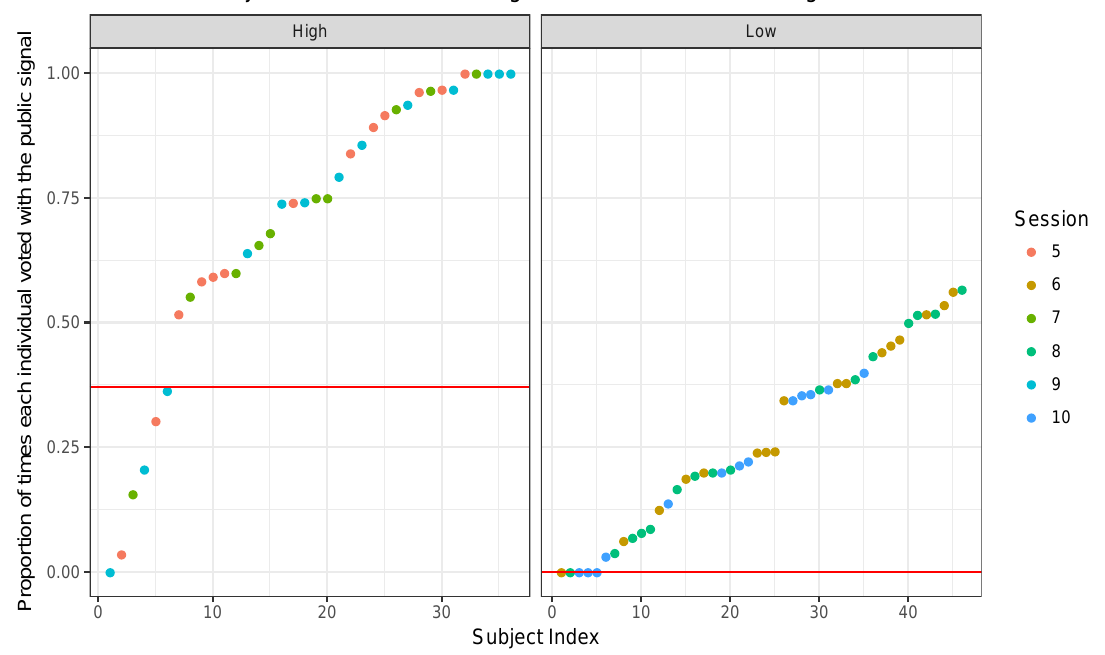
Figure A5. Proportion of times each individual voted according to the public signal in sessions 5–10 (with individual task). The left image plots values for sessions where Q > q , the right one Q < q . Different colors correspond to different sessions.